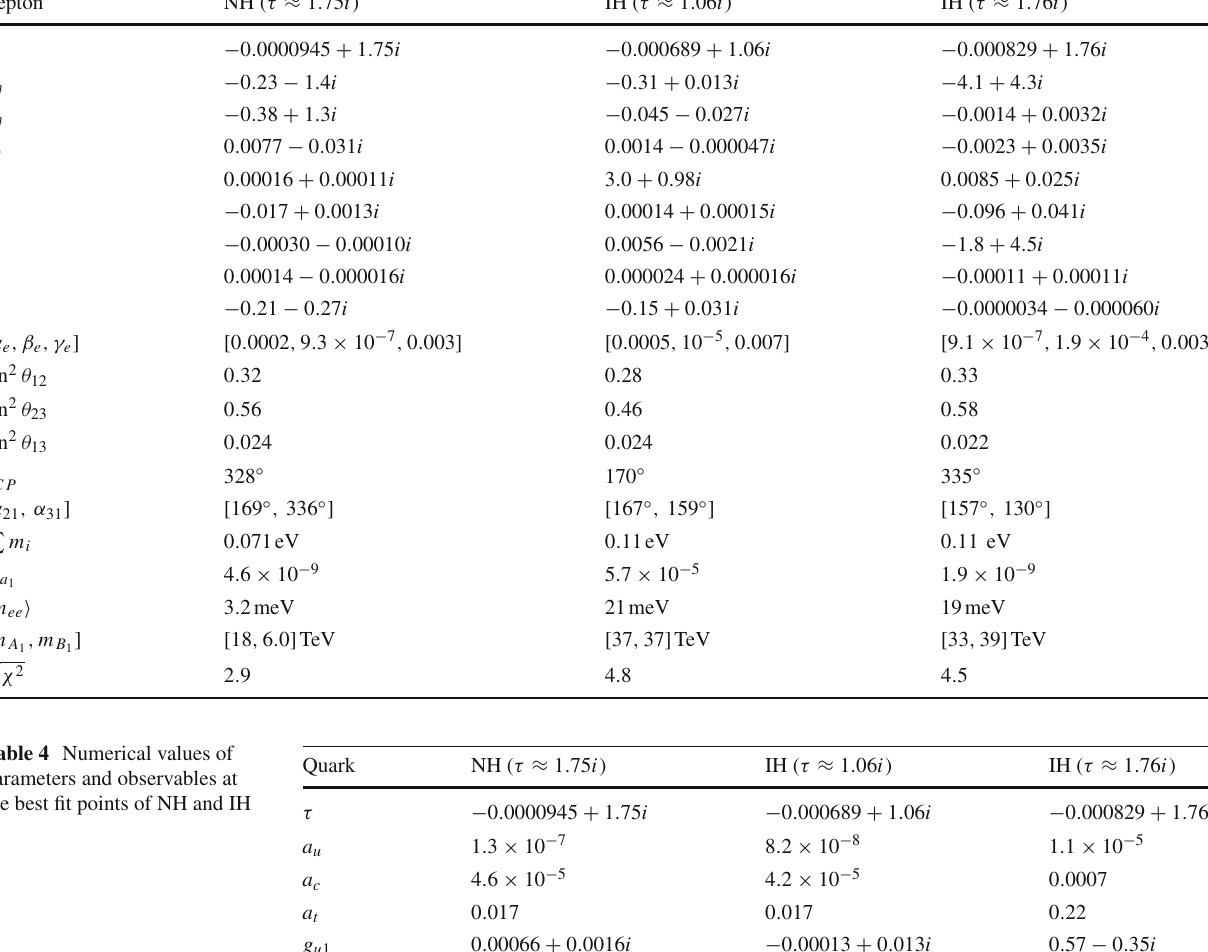
Table 3 Numerical values of parameters and observables at the best fit points of NH and IH Lepton